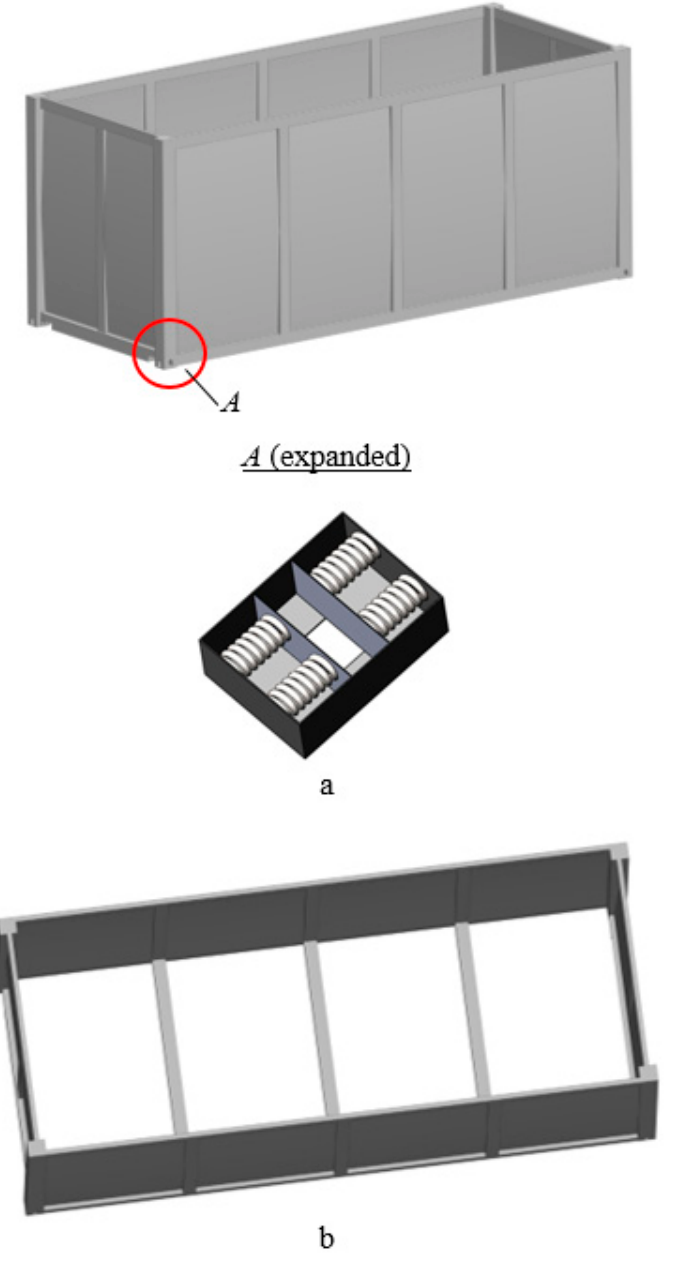
Figure 2. Flat Rack container with convex walls: ( a ) side view; ( b ) top view.